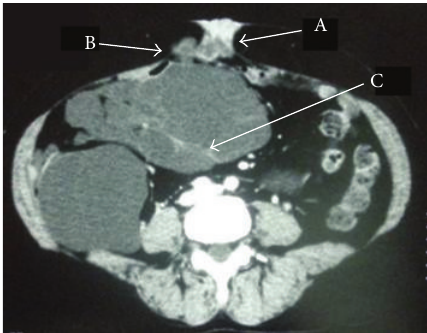
Figure 1: Computed tomography images of the BMPM: the arrows indicate the incisional hernia (A), multicystic mass surrounded to umbilicus (B), and intraabdominal extension (C).